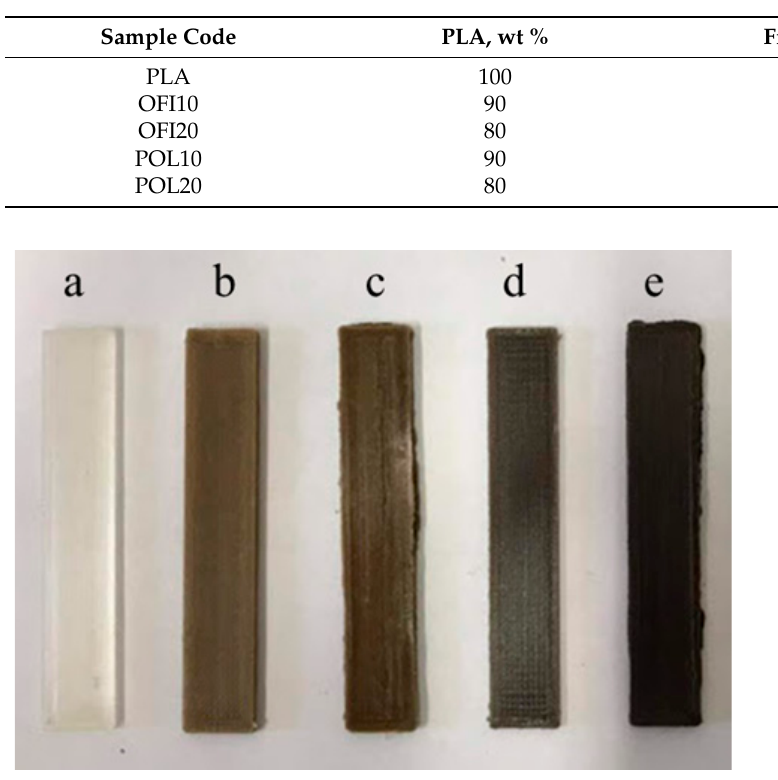
Figure 4. Representative specimens for tensile tests: PLA ( a ), OFI10 ( b ), OFI20 ( c ), POL10 ( d ) and POL20 ( e ).